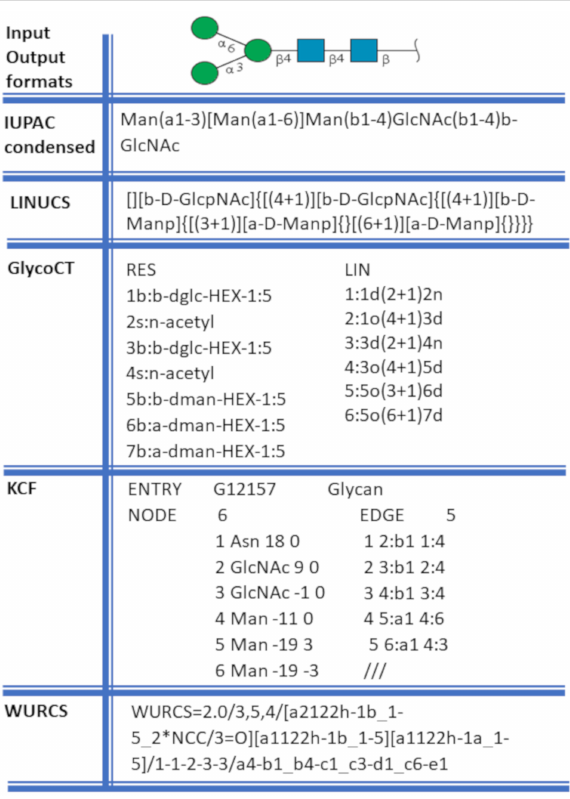
Figure 3: Examples of different glycan structure text formats for the same glycan. Data in these formats are generally used as input/output in glycan drawing and 3D structure building